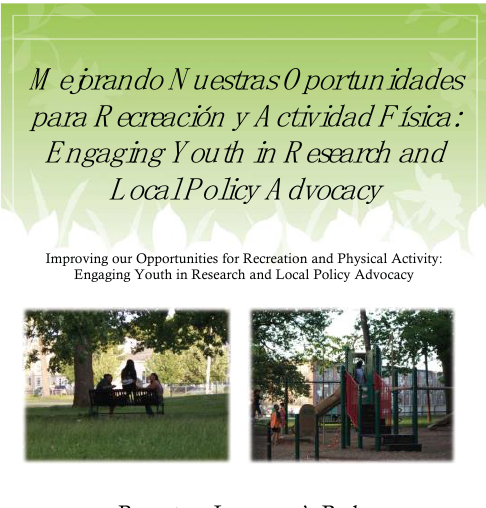
Figure 4. Cover page of final Report on Lawrence’s Parks [46].